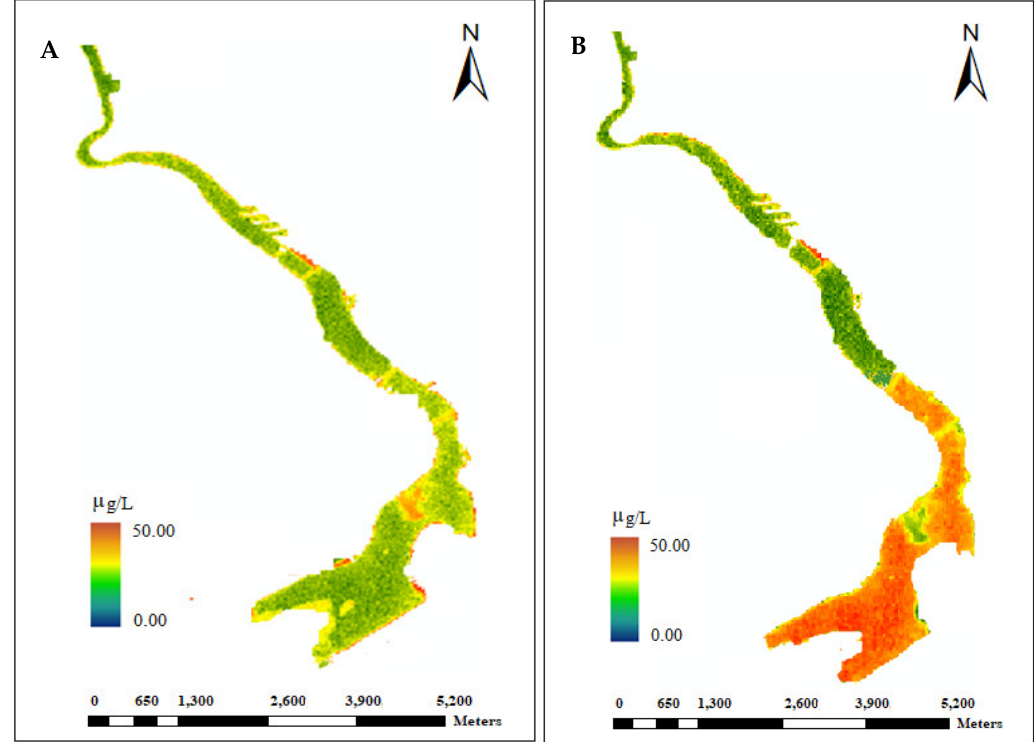
Figure 3. Chlorophyll-a derived from Landsat 7 ETM+ image of ( A ) 20 May 2012, ( B ) 23 July 2012.